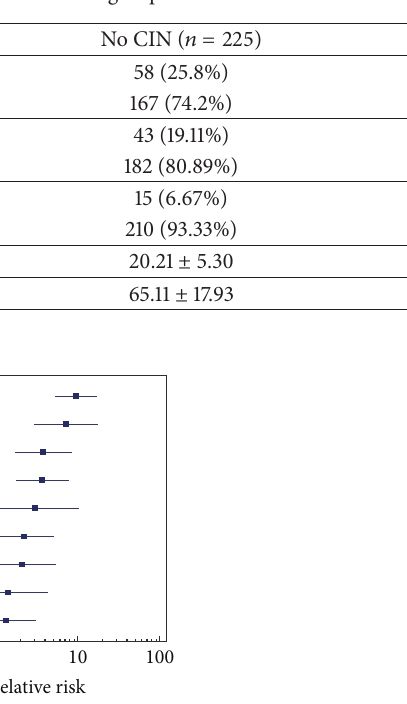
Table 3: Contrast characteristics in “CIN” and “No CIN” groups.